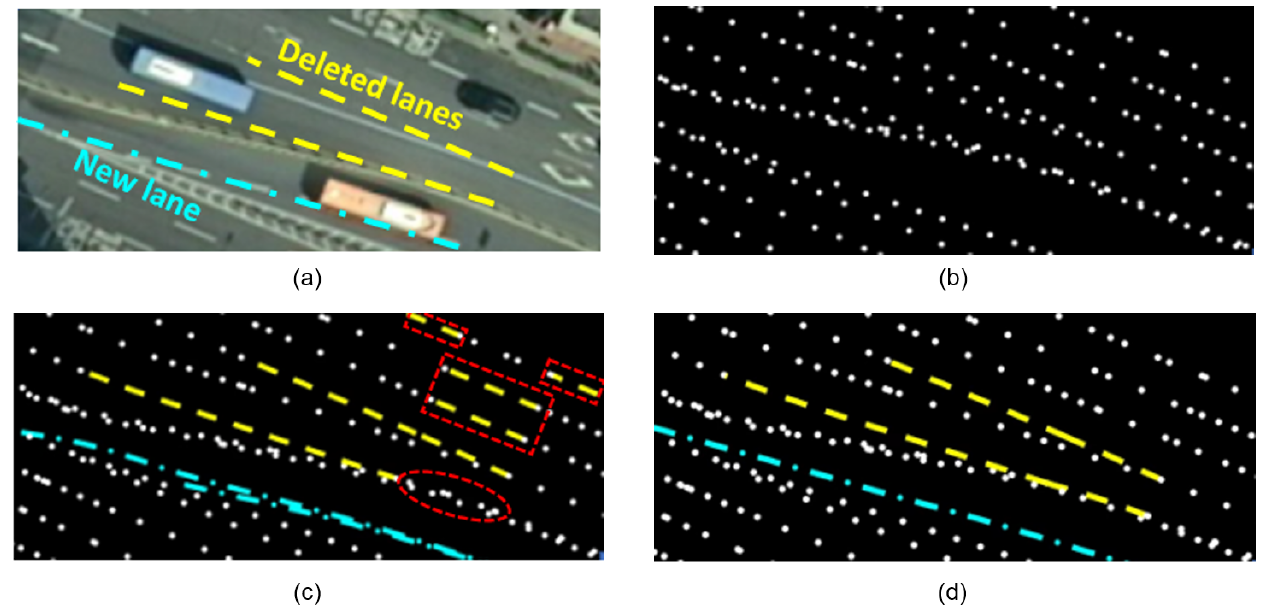
Figure 6. HD map update results of the previous and proposed method for Test area 1. ( a ) Aerial image of a road environment. ( b ) HD map before update. ( c ) HD map updated by the previous method. ( d ) HD map updated by the proposed method. An aerial image is presented as the ground truth in ( a ). In ( b – d ), different landmark classes are represented using different line styles and colors. Normal , Deleted , and New correspond to a white dotted line, yellow dashed line, and cyan dash-dotted line, respectively. In ( c ), dotted squares represent the areas where actual Normal lanes were falsely predicted as Deleted . In addition, a dotted ellipse shows the area where an actual Deleted lane was predicted as Normal